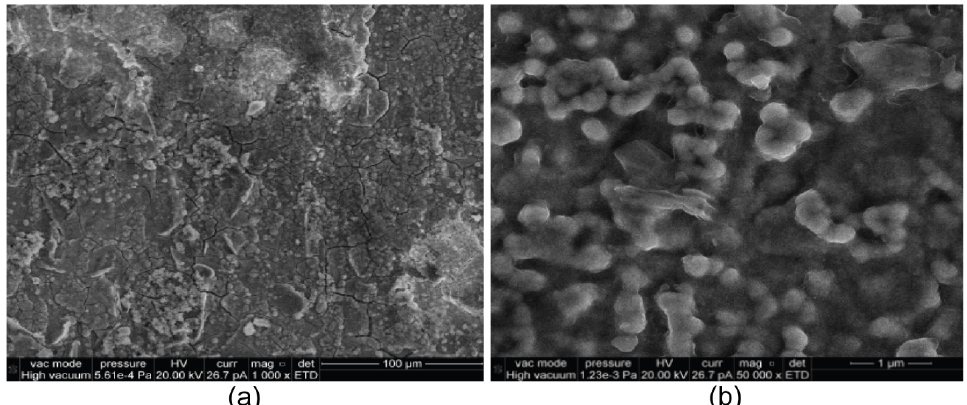
Figure 11. SEM morphology of the CoCrFeMnNi (film electrodeposited at −2.1 V for 90 min) corroded in artificial seawater: ( a ) ×1000; ( b ) ×50000.